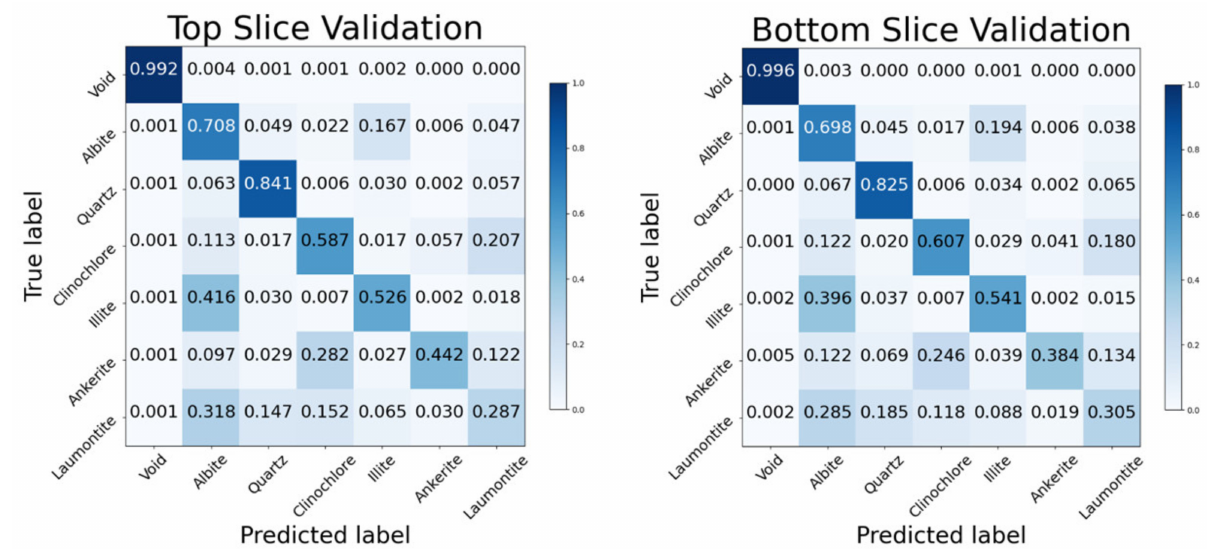
Figure 9. Confusion matrices showing the predicted deep learning and true µ XRF mineral pixel classifications for the validation data collected from the surfaces within the bulk of the basaltic andesite rock sample.